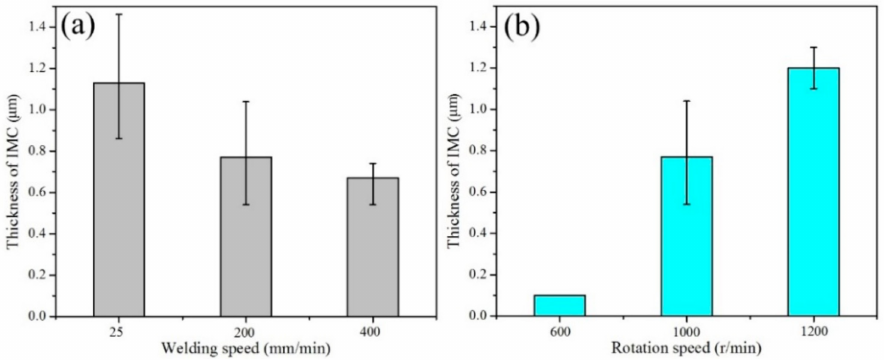
Figure 14. The variation of IMC thickness at the interface with different welding parameters. ( a ) Variation of the welding speed; and ( b ) variation of the rotation